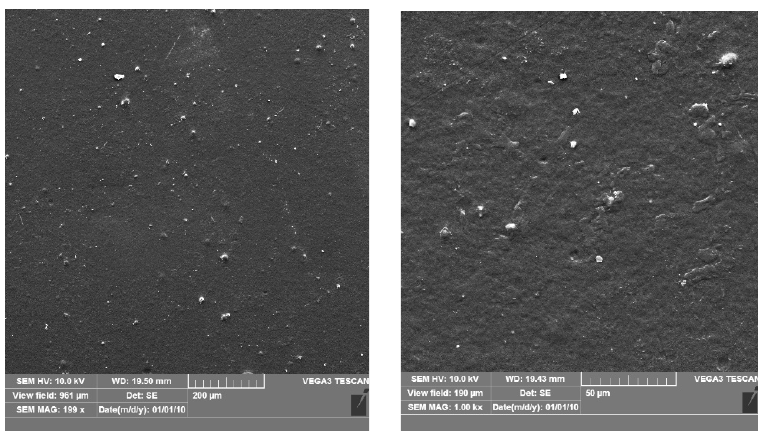
Figure 2. The PE film.